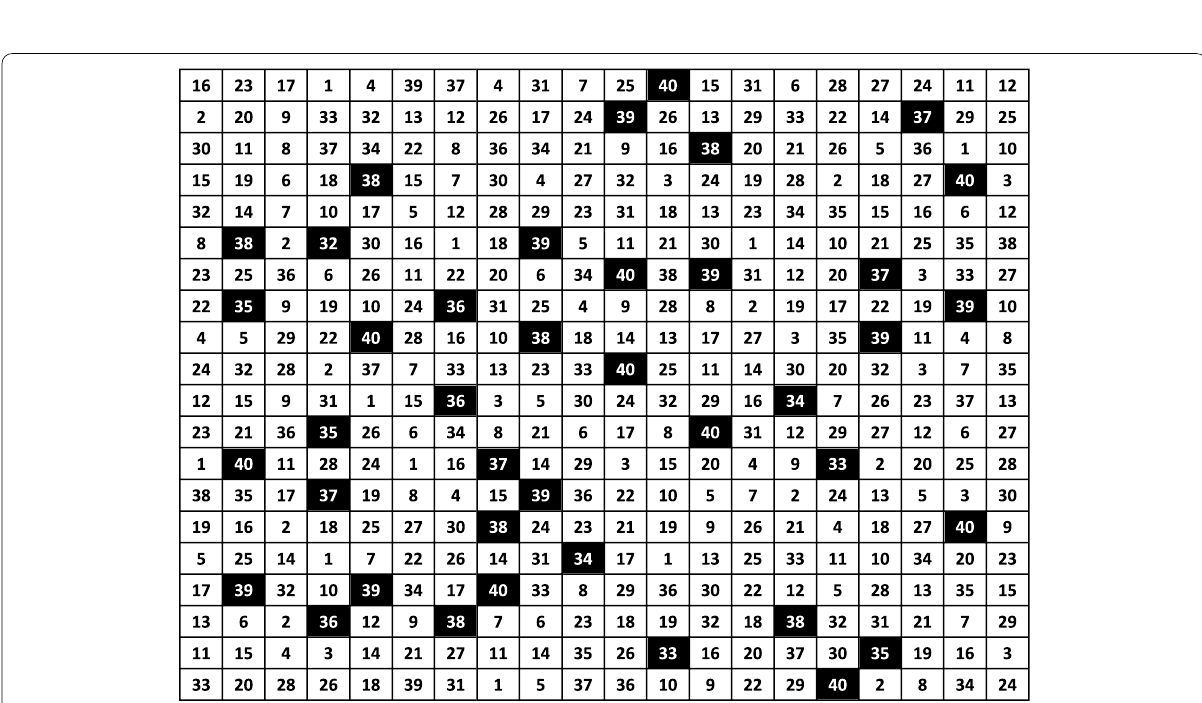
Fig. 3 The ONA seed orchard layout with 10% genetic thinning (black cells) following the Linear Deployment (declared ONA, GTL